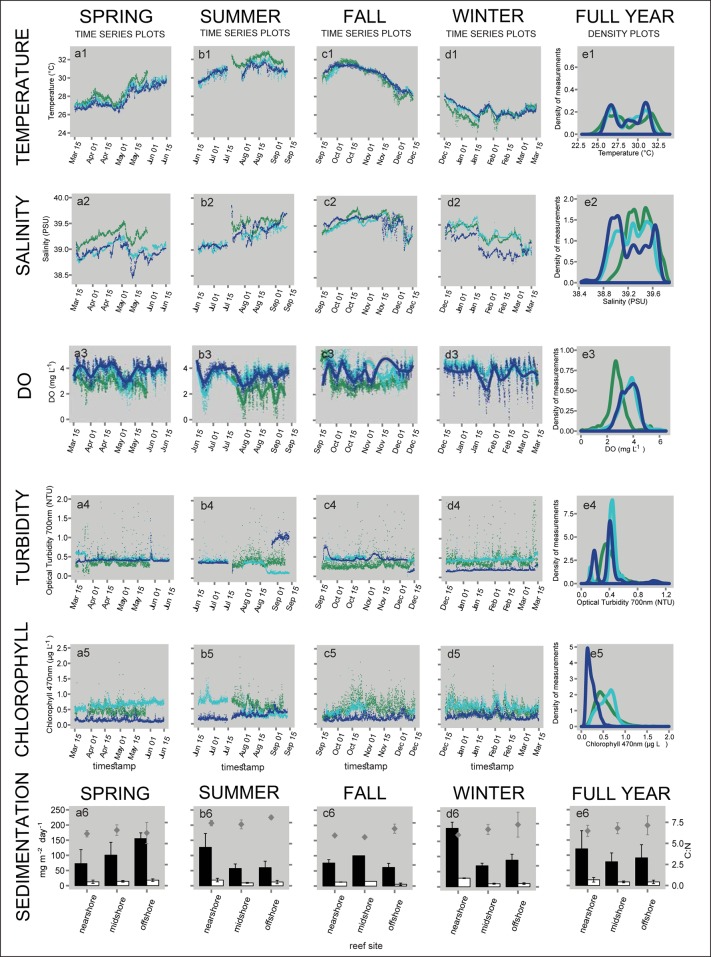
Physico-chemical variables of three coral reefs along a cross-shelf gradient over four seasons in the central Red Sea during 2012–2013.Continuously logged data of temperature (a1-d1), salinity (a2-d2), dissolved oxygen (DO; a3-d3), turbidity (a4-d4), and chlorophyll-a (a5–d5) are shown as time series plots over each season. The DO time series was fitted by polynomial regression (LOESS, span = 0.2). Plots in the last column (e1-e5) summarize full year data using density plots (kernel density estimation) to display frequency densities of data points observed in each reef. In the density plot of DO, the winter data set was excluded, as data from the nearshore reef were missing for almost the entire season. Sedimentation variables (a6-e6) are presented in bar plots (means ± SD). Green = nearshore reef; light blue = midshore reef; dark blue = offshore reef; black bars = sedimentation rate; white bars = organic content of sediments; diamonds = C:N ratio of sediments. (Seasons: spring 2013, summer 2013, fall 2012, winter 2012–13)